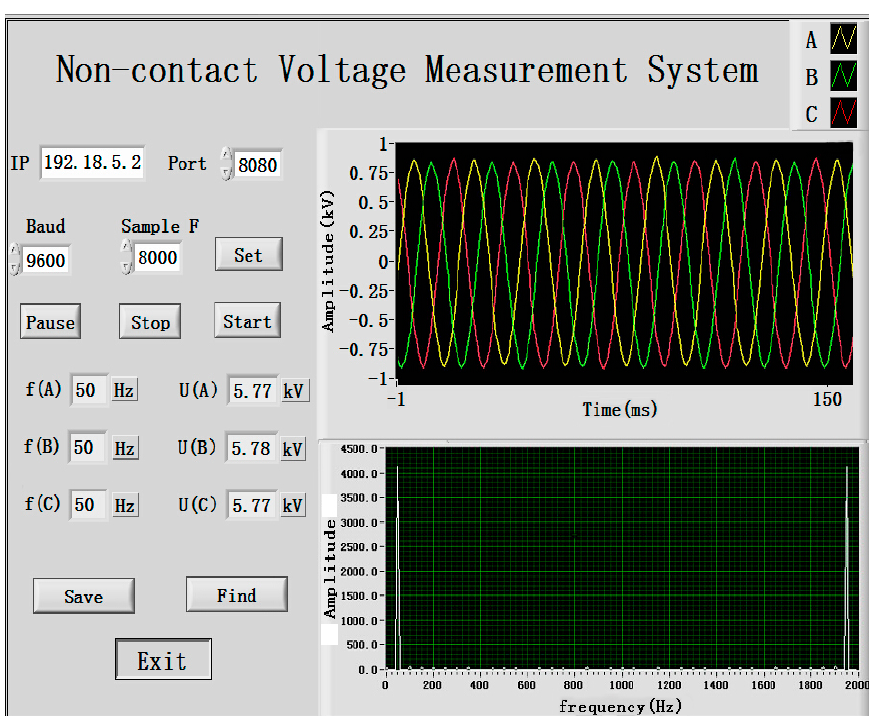
Figure 8. Interface of display on PC.